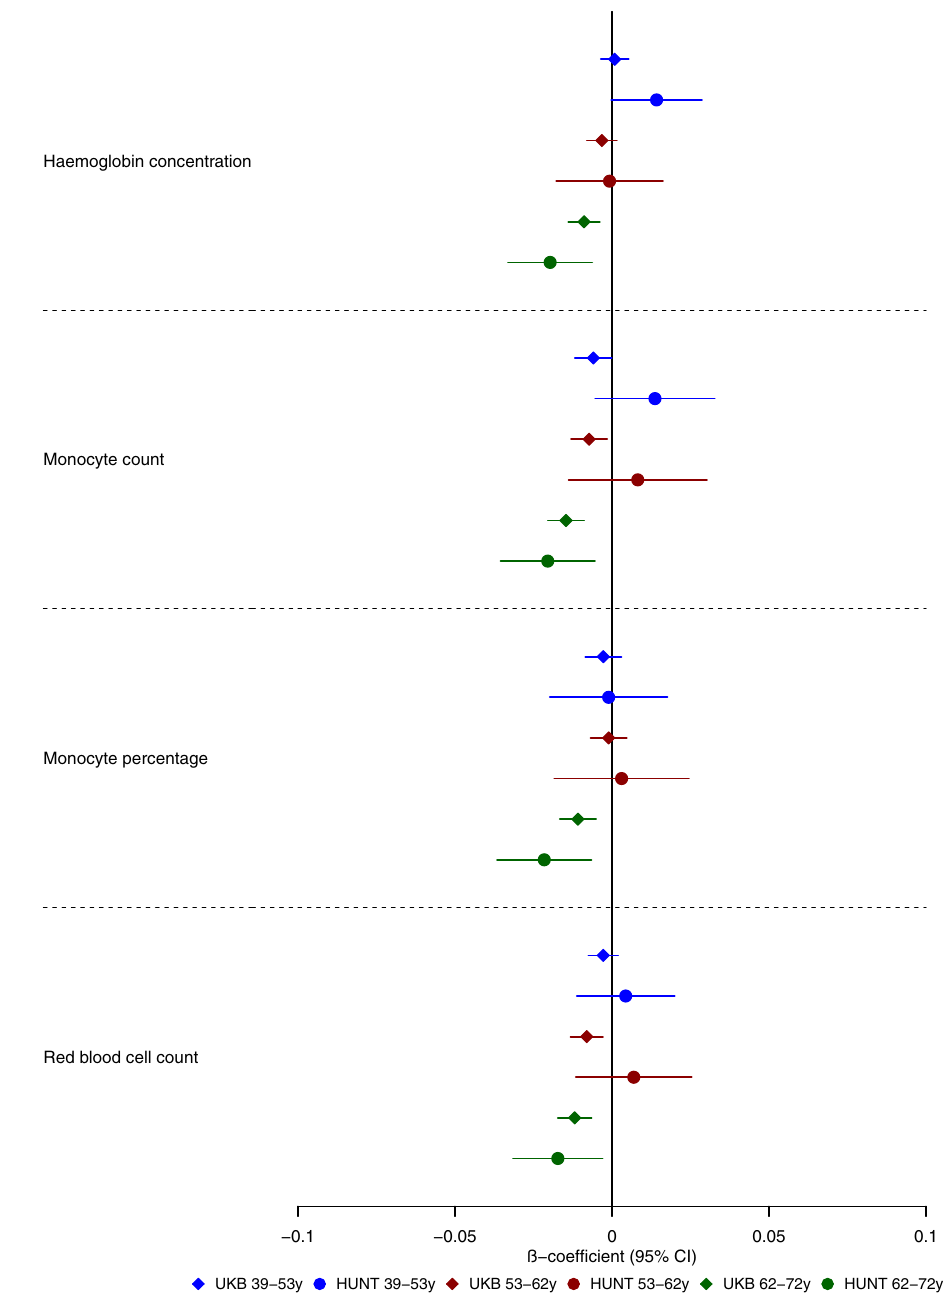
Fig. 6 | Forest plot showing the age-strati fi ed effect estimates for the associa- tion between the polygenic score for Alzheimer ’ s disease (including the APOE region) and blood-based biomarker measures in UK Biobank (diamond mar- kers) and HUNT (replication sample, circle markers). Legends at the bottom of each graph indicate age tertiles in both cohorts. The colors represent blue, the youngest age tertile(39 – 53years);red; middle age tertile(53 – 62 years);green, the oldest age tertile (62 – 72 years). Effect estimates represent an SD change in the